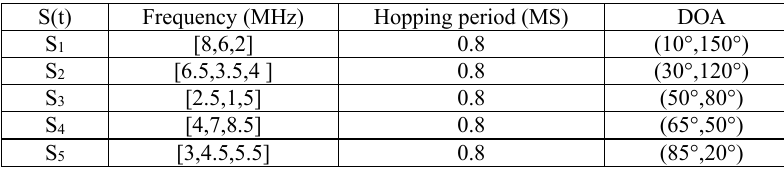
Table 1. Source signal parameter